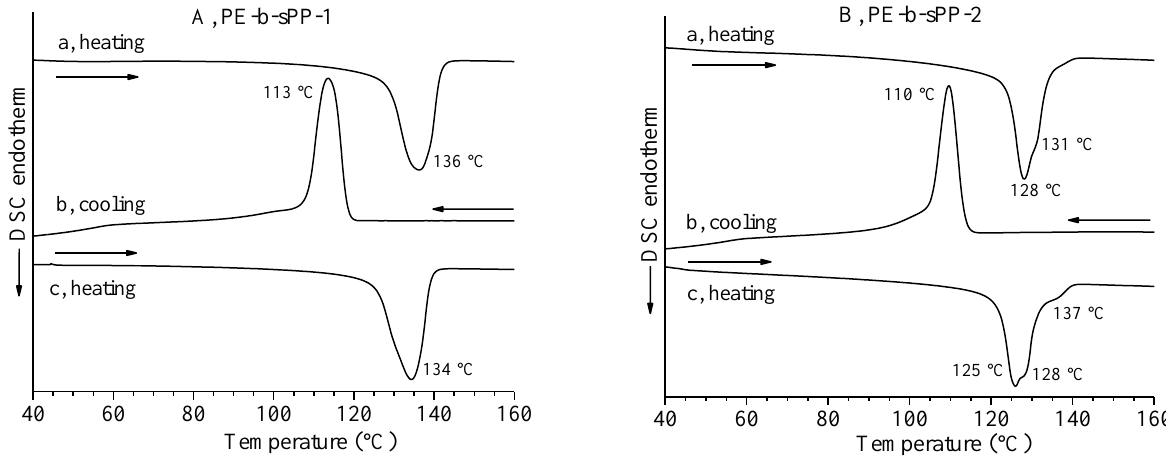
Figure 2. DSC curves recorded during heating of the as-prepared samples (a), cooling from the melt (b) and successive second heating of the melt-crystallized samples (c) of samples PE-b-sPP-1 ( A ) with f sPP = 53% and PE-b-sPP-2 ( B ) with f sPP = 75%. All thermograms have been recorded at a scanning rate of 10 °C/min.